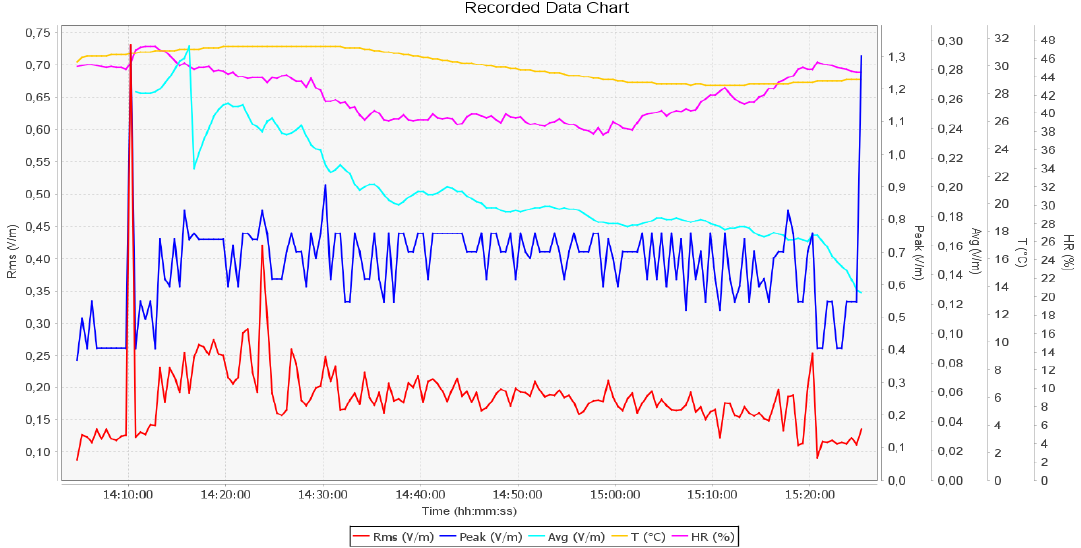
Figure 5. The intensity of the electrical component of the electromagnetic field in the course of flight no. 3 for the Aero AT3.